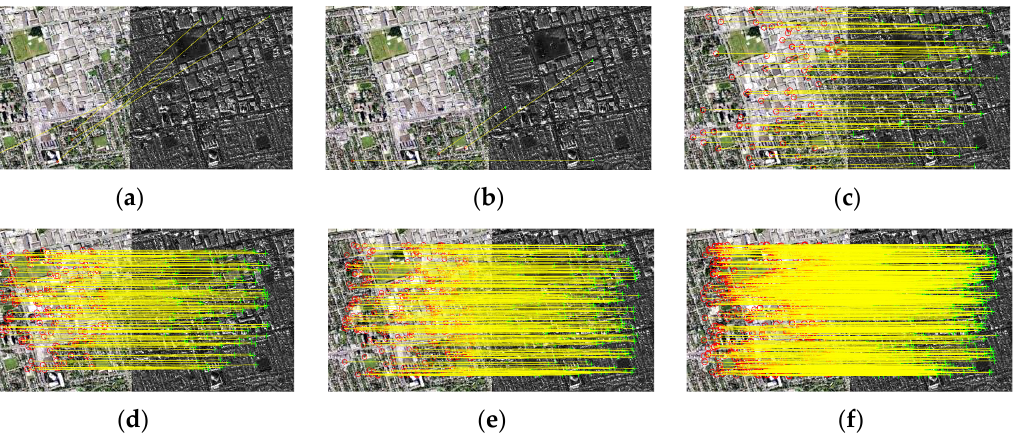
Figure 15. Experimental results of pair 3. The registration results from ( a ) to ( f ) are SIFT, SAR-SIFT, OS-SIFT, HOPC, RIFT, and MSPCO, respectively.